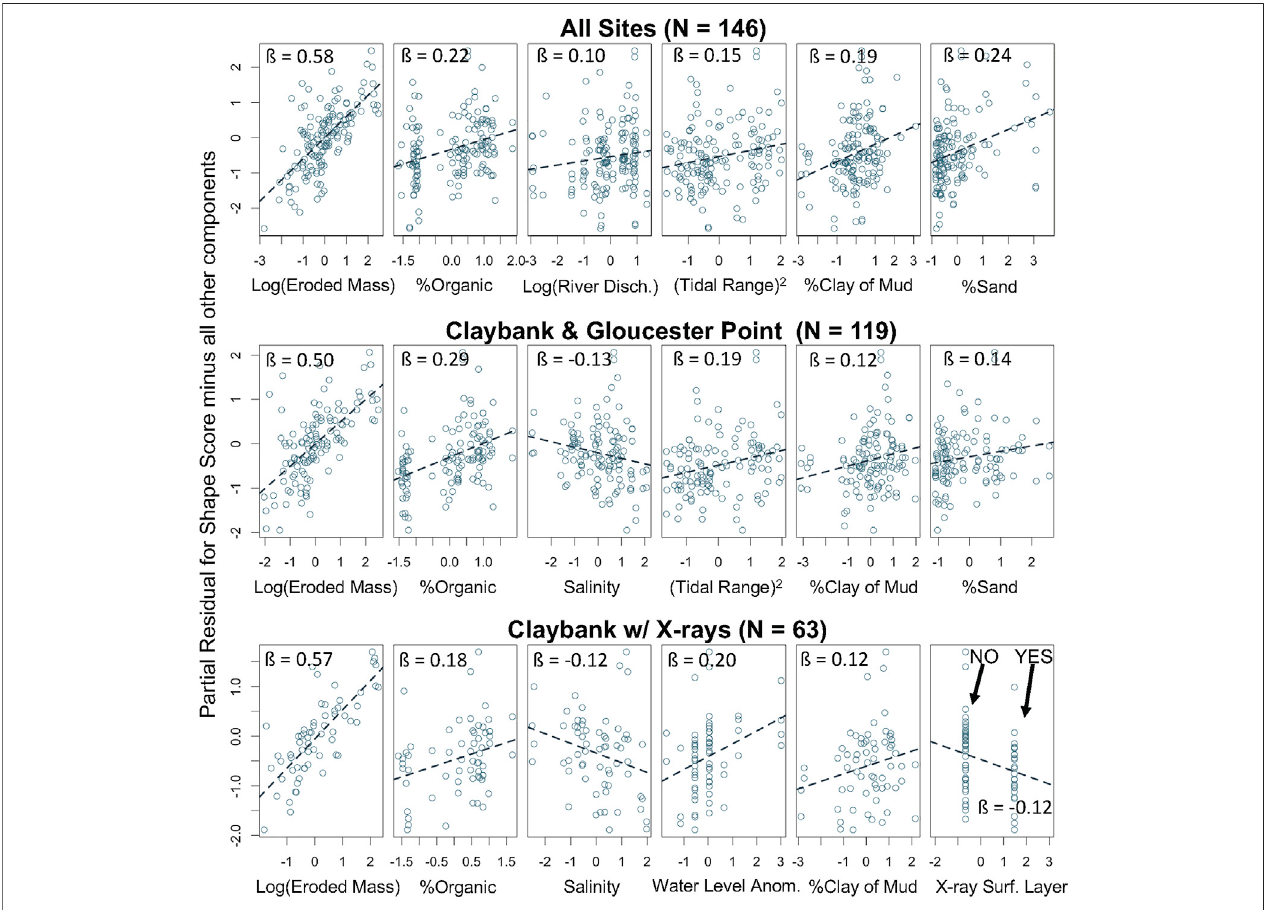
FIGURE 9 | As in Figure 8, but from the Erosion Shape Model Set for representative 6-component models.